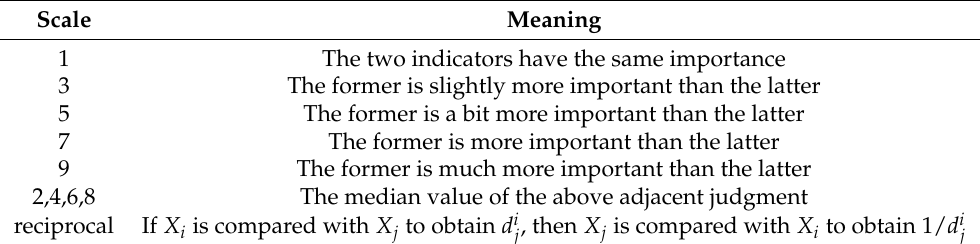
Table 4. Nine-grade scale method.